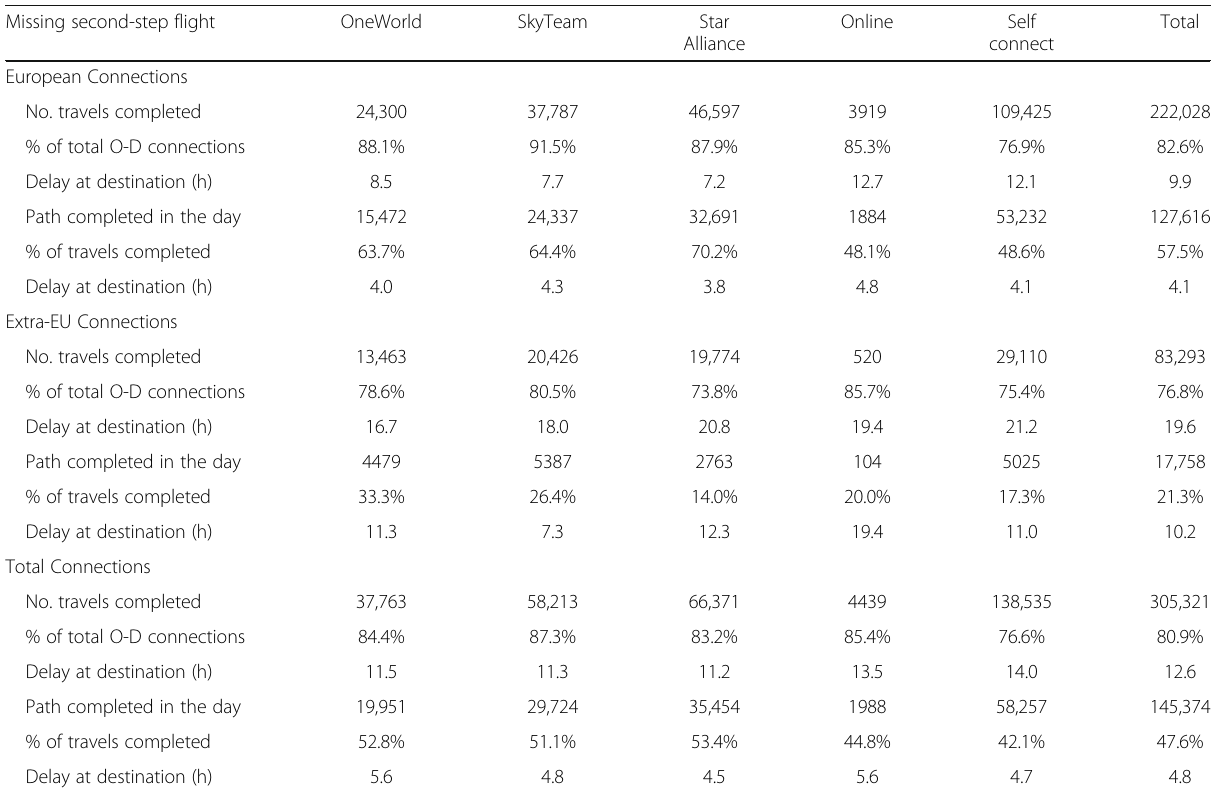
Table 9 Number of travels completed and delay at destination in case of missed the second-leg flight by connection type and geographical regions Missing second-step